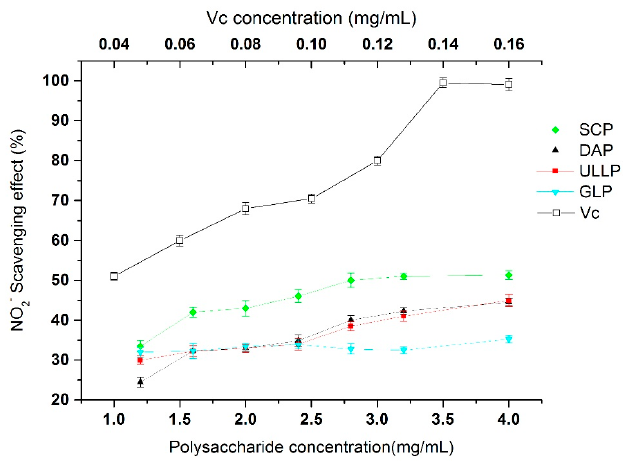
Figure 6. NO 2 − scavenging activities of GLP, DAP, SCP, ULLP, and Vc. GLP, DAP, SCP, and SCP are polysaccharides extracted from G. lemaneiformis , D. antarctica , S. ceylonensis , and Ulva lactuca L., respectively.